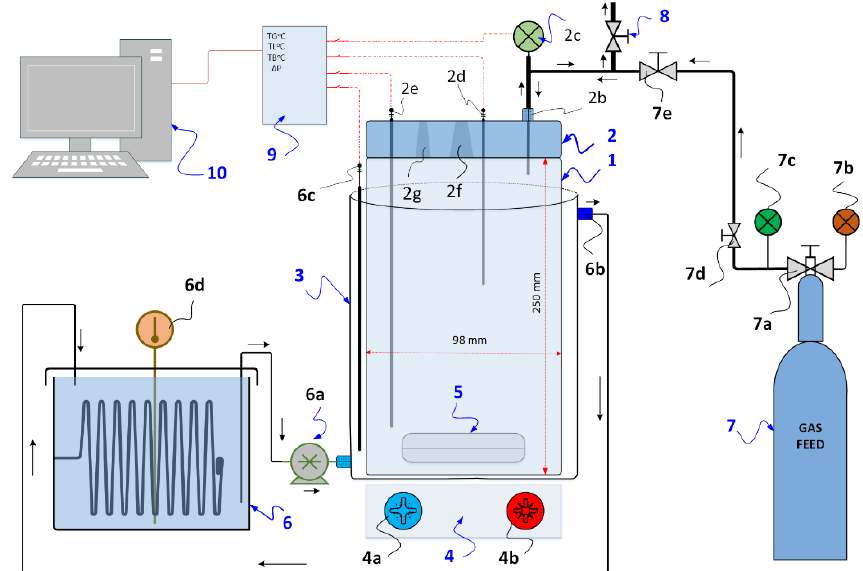
Figure 1. Experimental layout of submerged cooled clathrate hydrate reactor: (1) hydrate reactor; (2) reactor lid (2b: gas feed; 2c: reactor pressure transmitter; 2d/2e: gas and liquid thermocouple; 2f/2g: watch glass for camera and LED); (3) submerged chilling bath; (4) stirring plate (4a: rpm controller; 4b: heating controller); (5) magnetic bar; (6) chiller (6a/6b: coolant pump in/out; 6c: coolant thermocouple); (7) high-pressure gas cylinder (7a: cylinder pressure valve; 7b: cylinder pressure gauge; 7c feed pressure gauge, 7d: feed pressure valve; 7e: feed pressure valve controller; (8) reactor pressure relief valve; (9) – (10) data acquisition system.